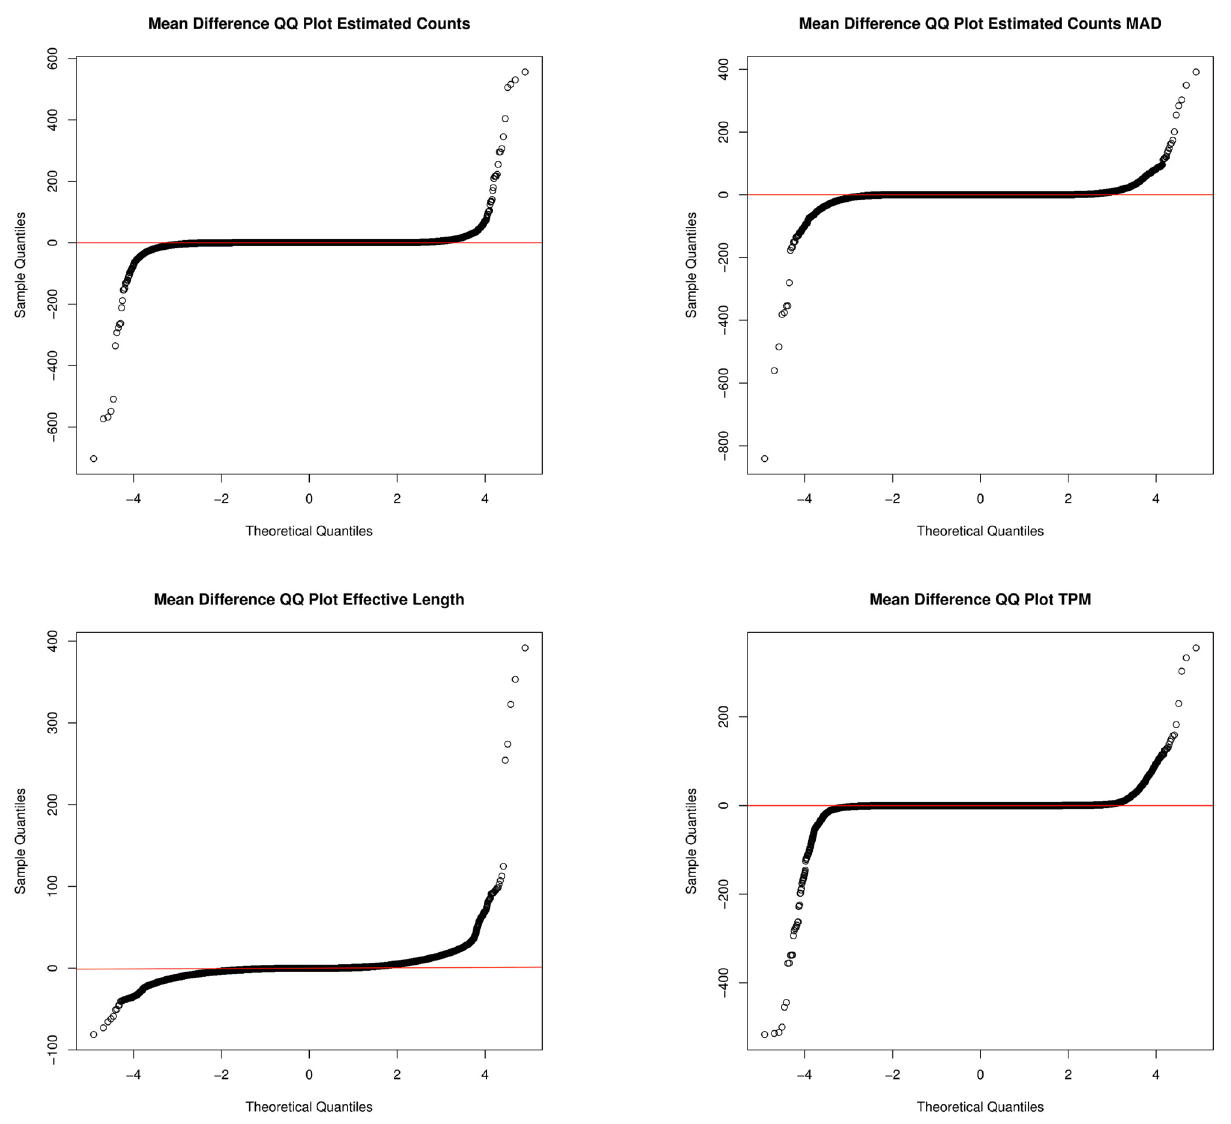
Figure 5. Quantile-Quantile Plots of Data Variation Comparing Differences in Kallisto Data from Versions 0.43.1 and 0.43.0. The X-axis depicts the theoretical quantiles of the standardized mean differences. The Y-axis represents the observed quantiles of standardized mean